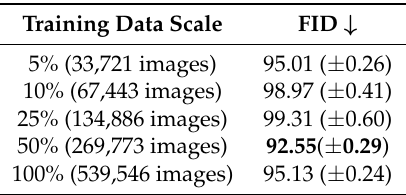
Table 3. Comparison of the impact of the training data scale on the C2C market dataset. In the unsupervised setting, the C2C market dataset at 50% scale is superior to other scale settings.